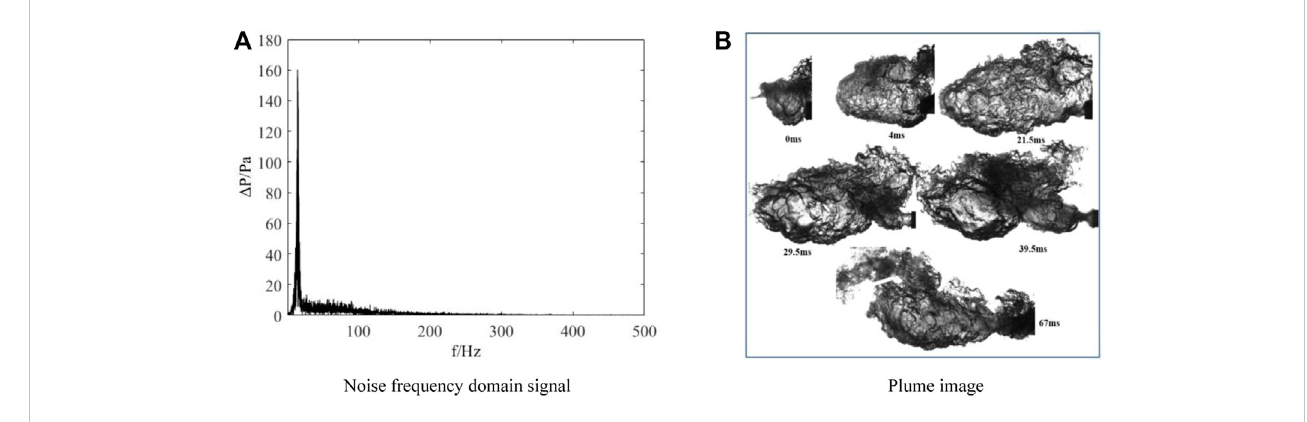
FIGURE 9 Ge = 160 kg/m 2 · s; Δ T = 3 ° C.